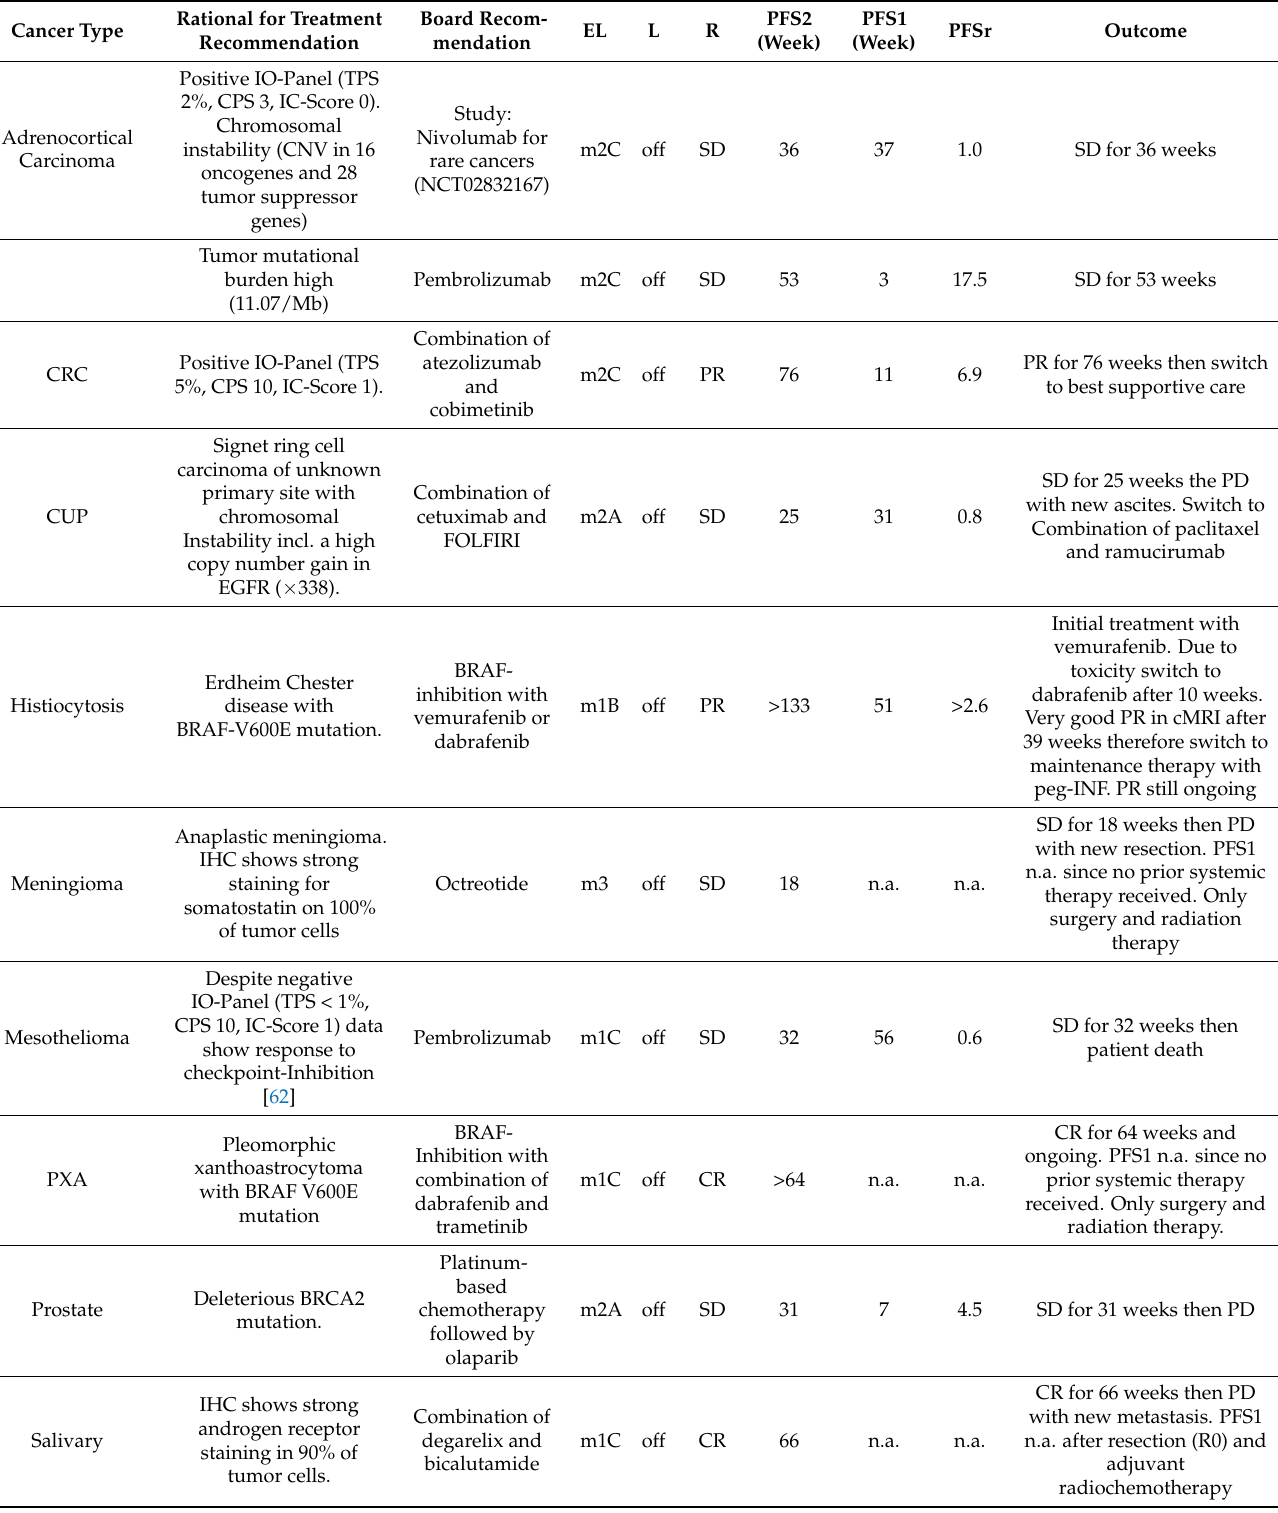
Table 3. Patients with disease control under off-label treatment since